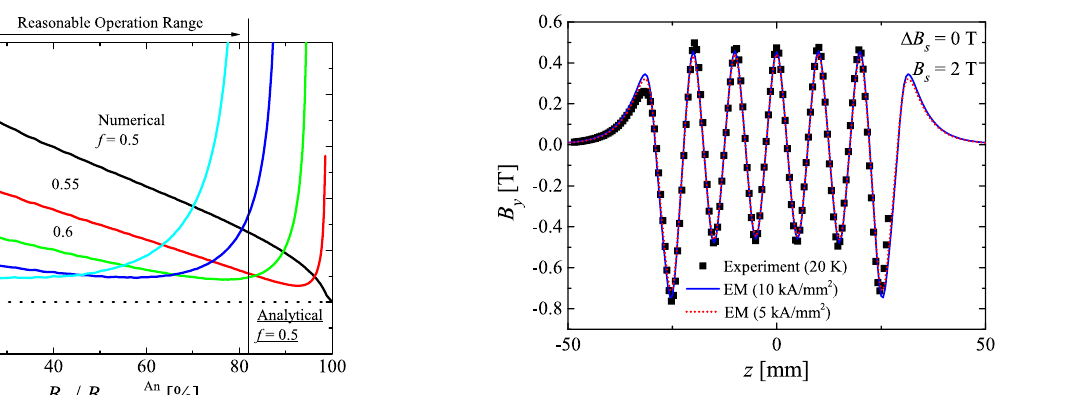
FIG. 7. Difference in the analytical and numerical values of Δ B required for the same B 0 (analytical and EM, g= λ s The superscripts An and Nu indicate analytical and numerical values, respectively. The numerical calculation was performed by the EM method with N ¼ 12 .